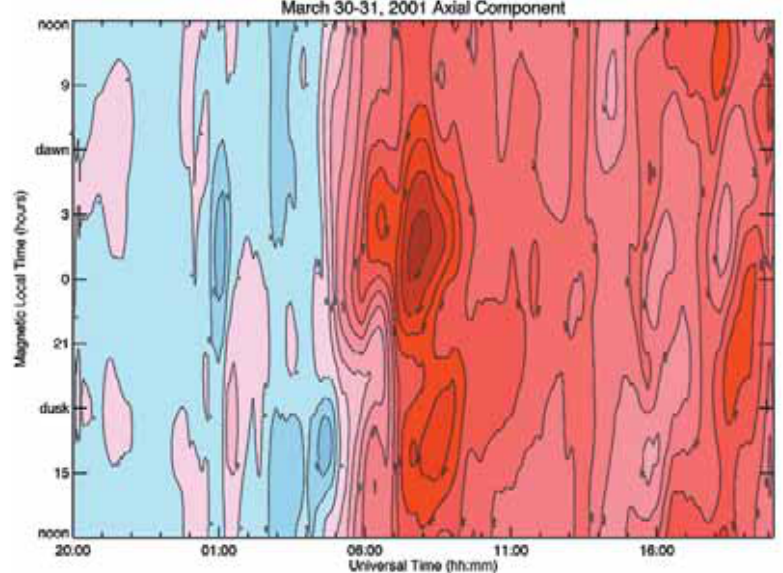
Fig. 11. A MLT-UT map of the H component of the world-wide magnetic disturbance field measured by 19 low-latitude ground magnetic observatories from 20:00 UT on 30 March 2001 to 20:00 UT on 31 March 2001. The quiet-time field has been removed from the data using observations from the quiet day 15 March 2001. The contour step is 50nT, with blue indicating positive disturbances and red negative disturbances (Skoug et al.,